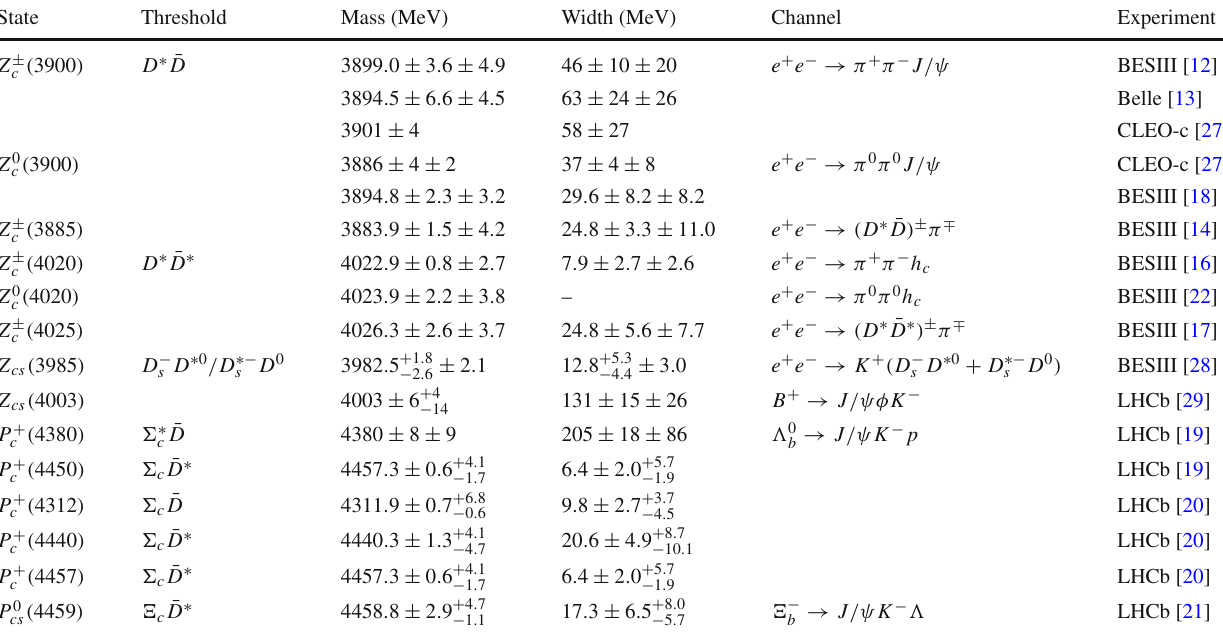
Table 1 A summary the experimental information of Z c / Z cs and P c / P cs